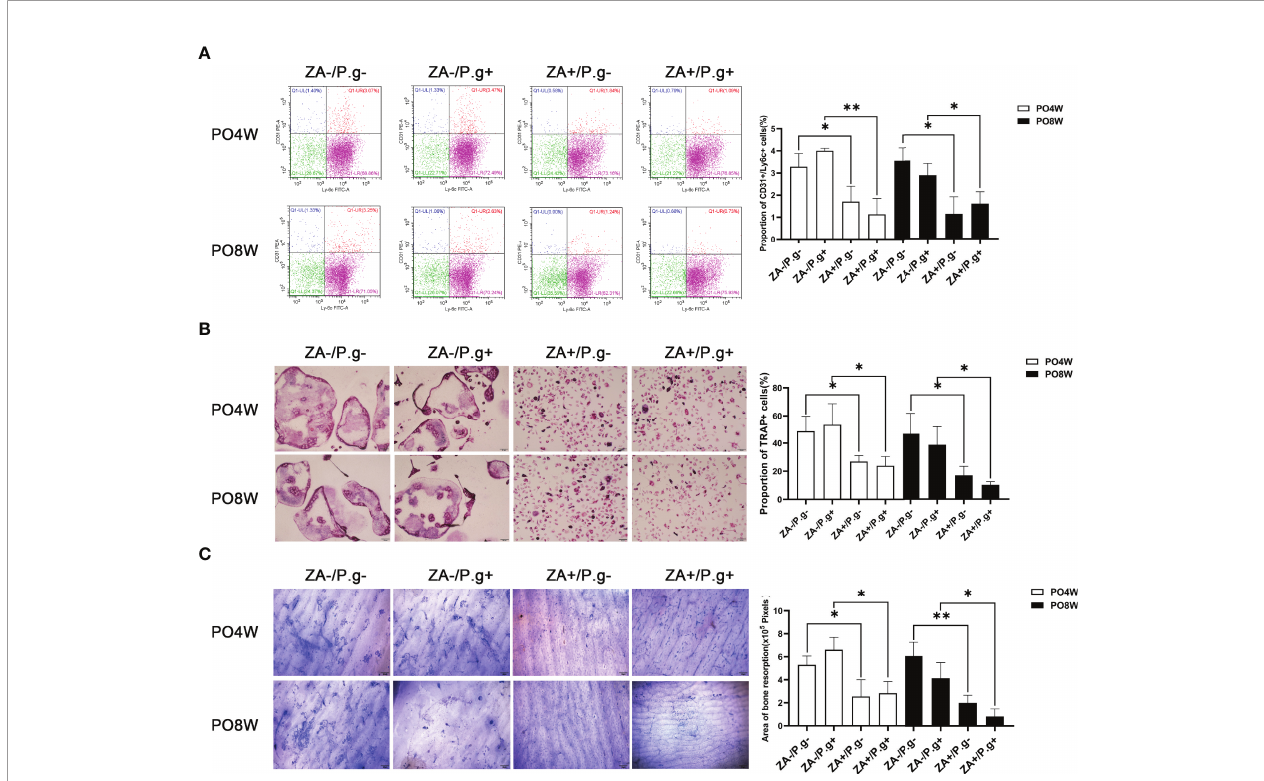
FIGURE 4 | Osteoclastogenesis and bone resorption by OCPs extracted from femurs was inhibited by ZA administration but not by P. gingivalis infection. (A) Flow cytometry analysis showed the proportion of Ly6C + /CD31 + cells in the ZA-treated groups (ZA+/ P.g - and ZA+/ P.g + groups) was lower than that in the ZA-untreated groups (ZA-/ P.g - and ZA-/ P.g + groups) at 4 and 8 weeks postoperatively. While there was no statistical difference in the proportion of Ly6C+/CD31+ cells between the P. gingivalis -treated (ZA-/ P.g + and ZA+/ P.g +) and P. gingivalis -untreated (ZA-/ P.g - and ZA+/ P.g -) groups at 4 and 8 weeks postoperatively. (B) TRAP staining showed the number of TRAP+ multinucleated cells in the ZA-treated groups was signi fi cantly lower than that of the ZA-untreated groups at 4 and 8 weeks postoperatively. While there was no statistical difference in the number of TRAP+ multinucleated cells between the P. gingivalis -treated and P. gingivalis -untreated groups at 4 and 8 weeks postoperatively. (C) Coomassie Brilliant Blue staining showed bone resorption area in the ZA-treated groups was smaller than that in the ZA-untreated groups at 4 and 8 weeks postoperatively. But no statistical difference was found in the bone resorption area between the P. gingivalis -treated and P. gingivalis -untreated groups at 4 and 8 weeks postoperatively. Bar: 50 m m, 20× magni fi cation. PO4W, postoperative 4 weeks; PO8W, postoperative 8 weeks. *p <0.05, **p